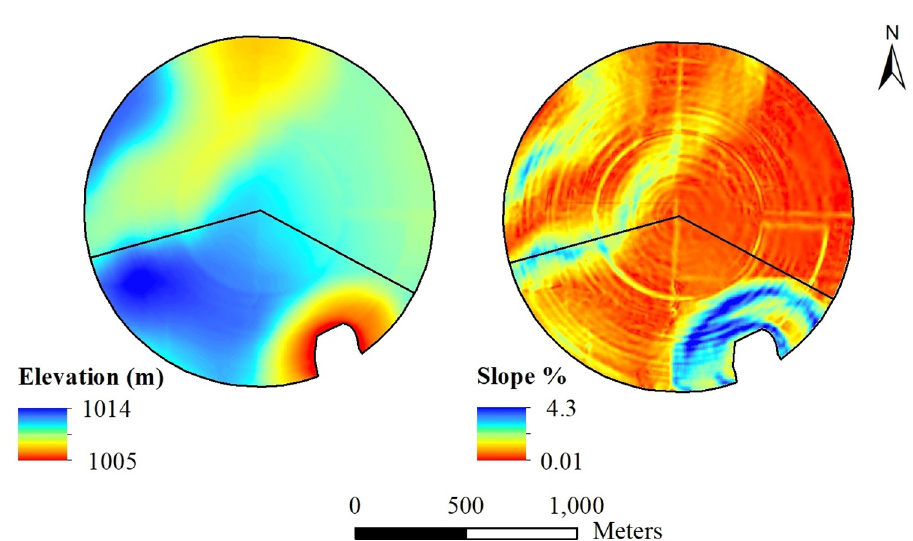
Fig 6. Variation in elevation and slope for two fields within a 194-ha farm in Hale County, Texas.